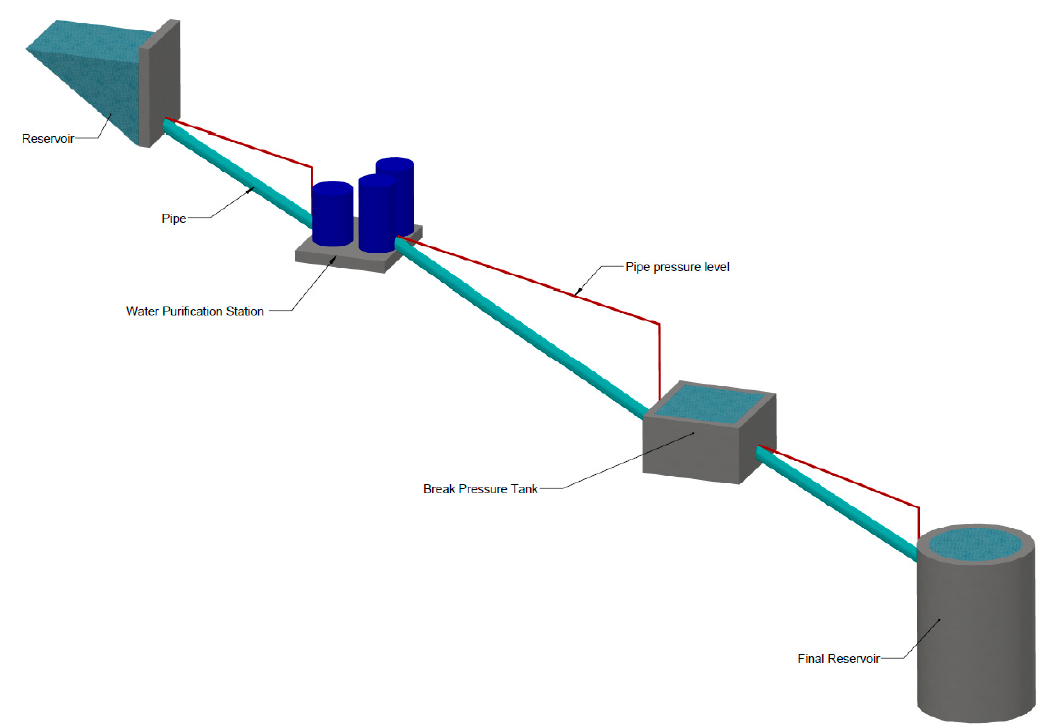
Figure 1. General scheme.